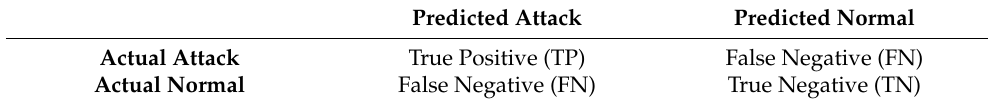
Table 3. Definition of the confusion